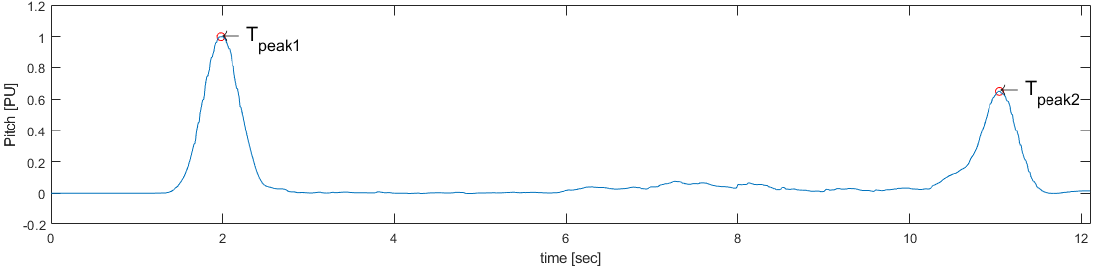
Figure 5. Peaks identified for the search of start and end of standing and sitting